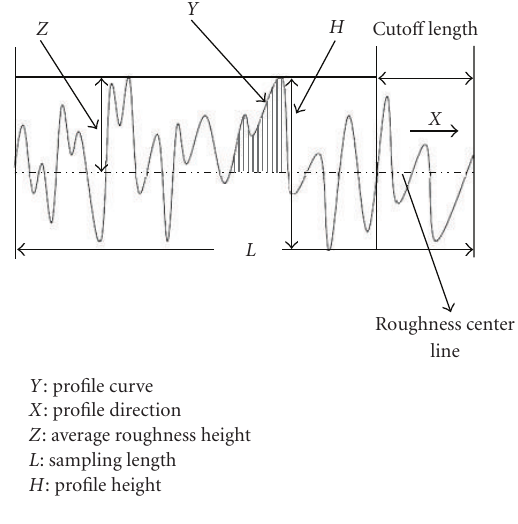
Figure 1: Surface roughness profile [13]. Table 1: The chemical composition of test specimens (weight %).